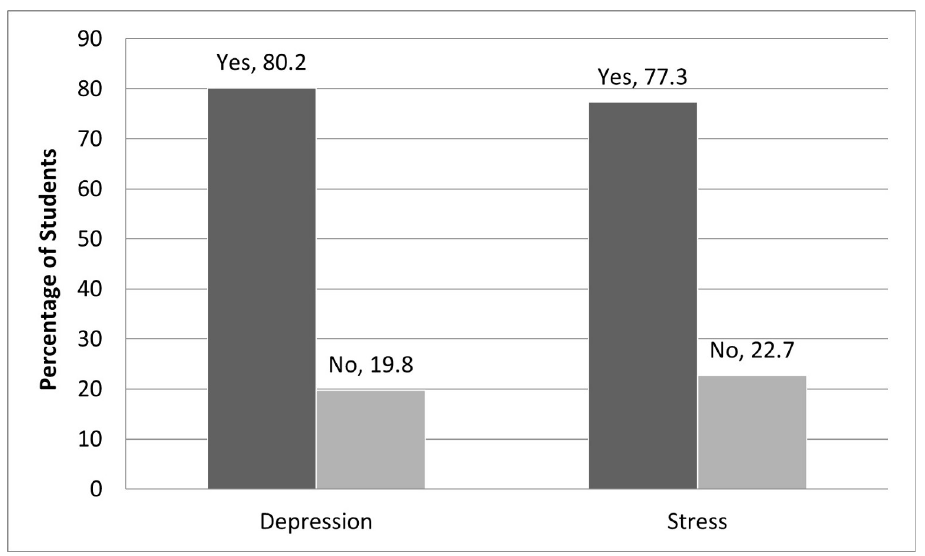
Fig 1. Distribution of students in the depression and stress